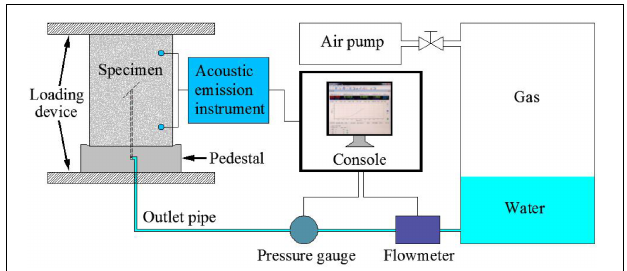
FIGURE 1 | Schematic of the developed test system.